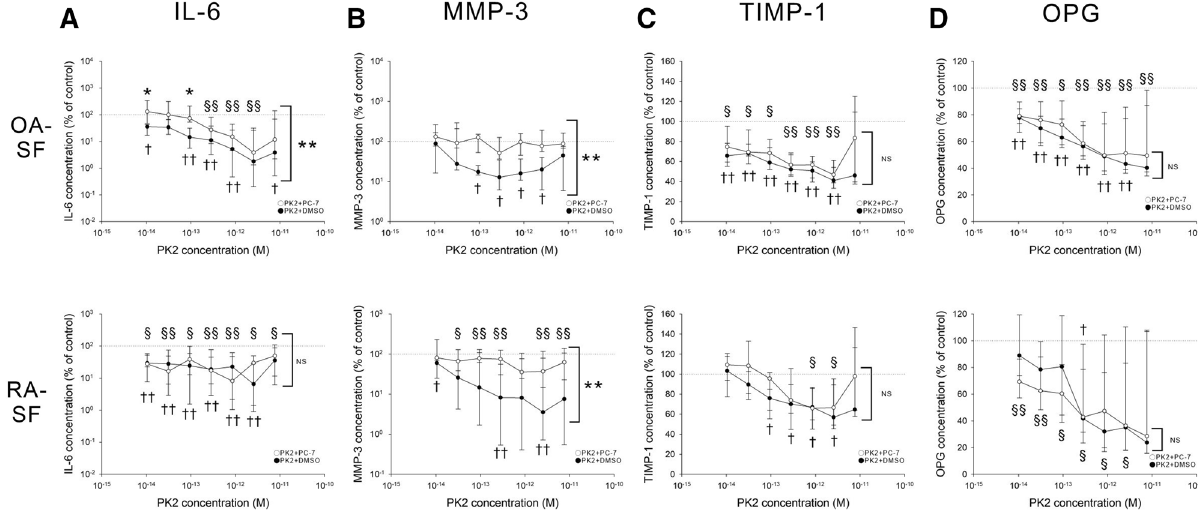
Figure 6. Influence of PK2 and PC-7 (or DMSO) on IL-6 ( A ), MMP-3 ( B ), TIMP-1 ( C ), and OPG ( D ) production from TNFα-prestimulated OA- and RA-SF. The dotted line indicates the control level of 100% (TNFα without PK2). All data are given as the median (25th percentile, 75th percentile). N = 8. In comparisons between DMSO and PC-7 groups, a two-way ANOVA followed by the Bonferroni post hoc test was used (*p < 0.05, **p < 0.01). In comparisons with a control level of 100%, the one-sample Wilcoxon signed-rank test was used (compared with the control in the PC-7 group: § p < 0.05 and §§ p < 0.01; compared with the control